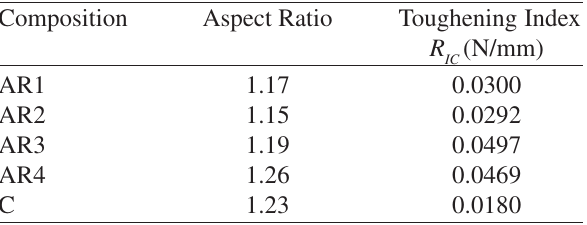
Table 2. Average values of and R in fired specimens.